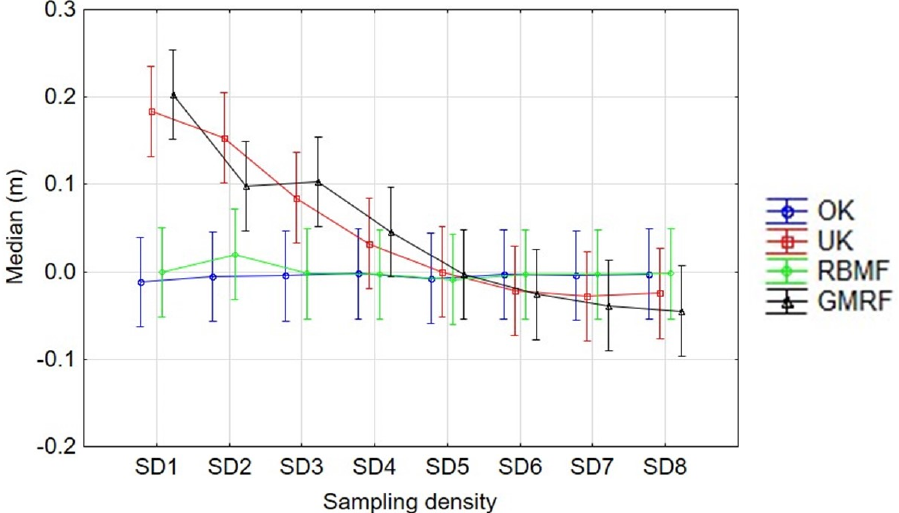
Figure 10. Trend graph of the median of the residuals (Z interpolated − Z checkpoint ) with respect to the interaction between Sampling Density and Interpolation Method. Vertical bars denote 95% confidence intervals.